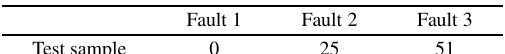
Table 1 Distances between test sample and each fault